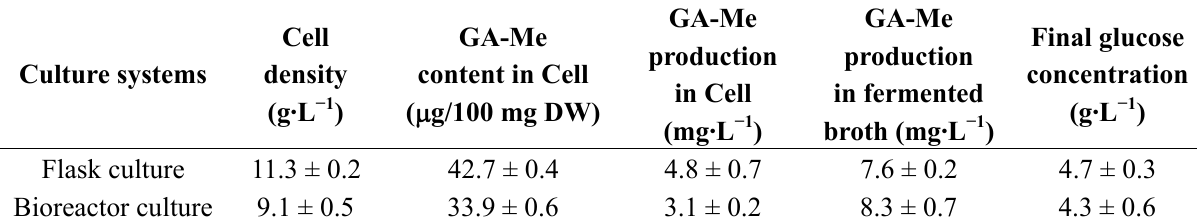
Table 6. Verification results for ganoderic acid Me (GA-Me) production under the optimized culture condition by G. lucidum